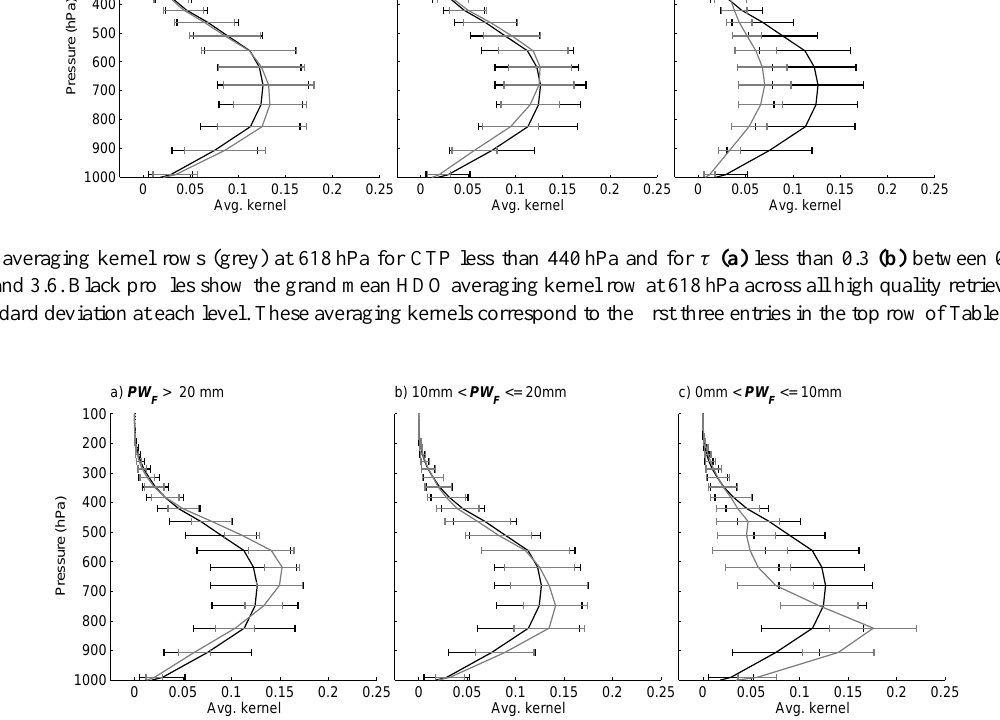
Fig. 7. HDO averaging kernel rows (grey) at 618hPa for CTP less than 440hPa, τ less than 0.3, PW B greater than 20mm, and PW F : (a) greater than 20mm (15% frequency, 81% quality) (b) between 10mm and 20mm (14% frequency, 79% quality) (c) less than 10mm (3% frequency, 82% quality). Black profiles show the grand mean HDO averaging kernel row at 618hPa across all high quality retrievals. Error bars show the standard deviation at each